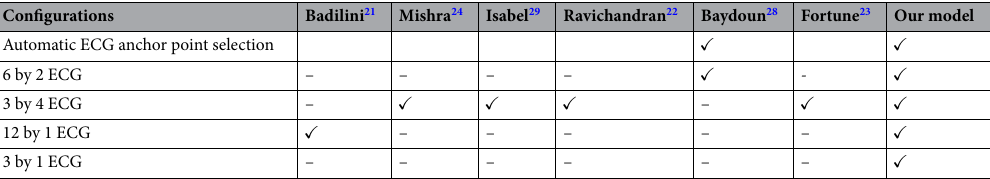
Table 8. Comparison of different ECG digitisation tools: Existing digitisation tools are specific ECG configurations or do not detect ECG anchor points by automated methods. By contrast, the automated tool presented here in can digitise ECGs of any configuration. (‘–’ suggests that it is unclear if the algorithm can process ECG